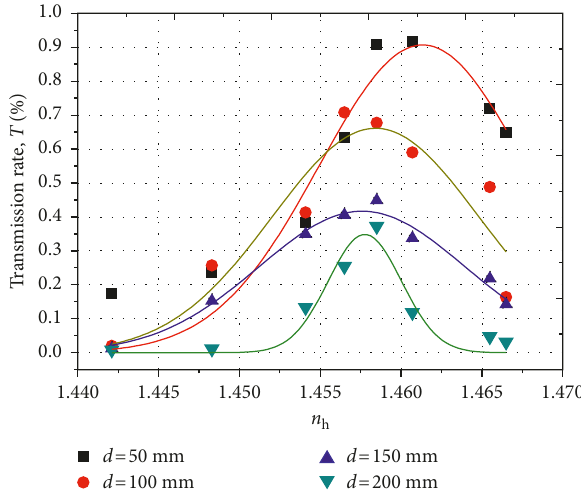
Figure 4: Relationship of transmittance T to refractive index